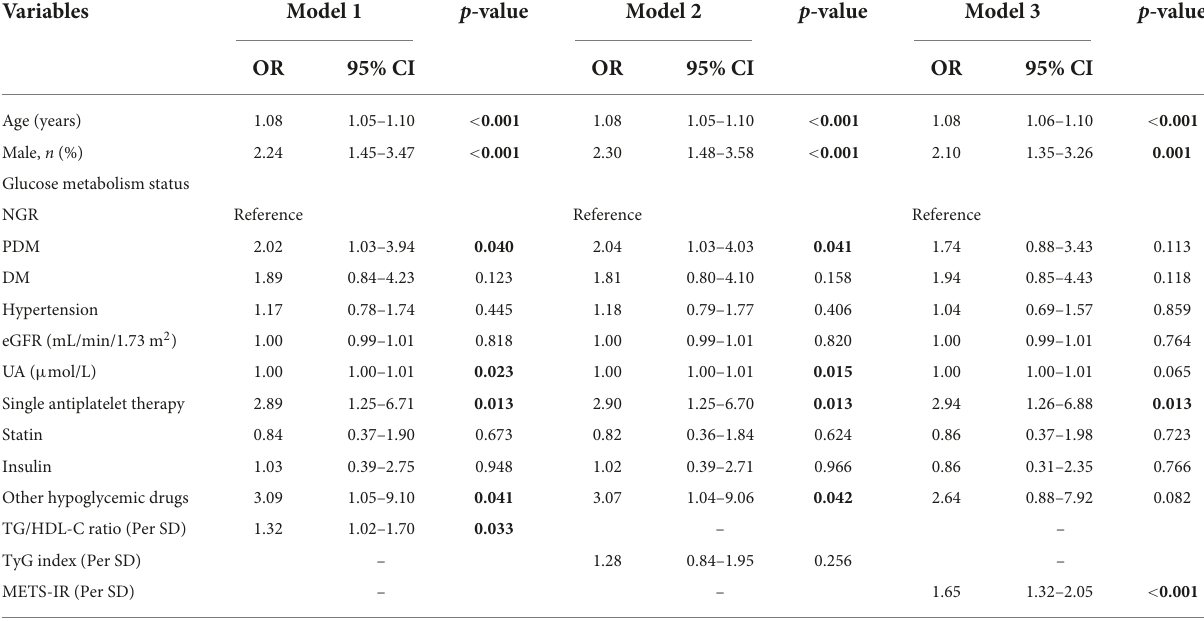
TABLE 4 Multivariate logistic regression analyses for the presence of